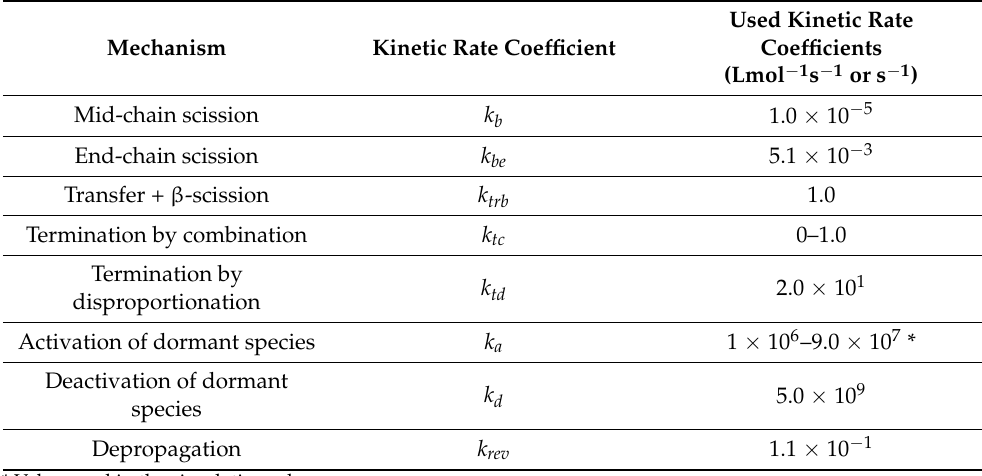
Table 5. Kinetic parameters used for the simulation of the pyrolysis of